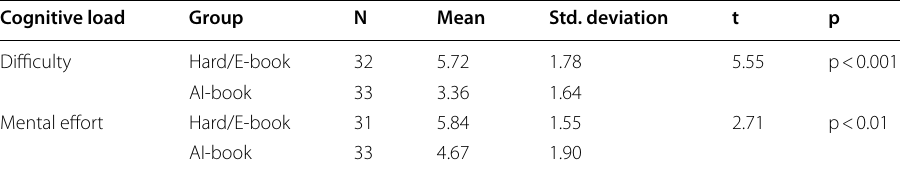
Table 3 Results from a t‑test comparing students’ cognitive load when using a hardcopy and/or E‑book for learning (2018) with the AI‑enriched book (2019) Cognitive load Group N Mean Std. deviation p